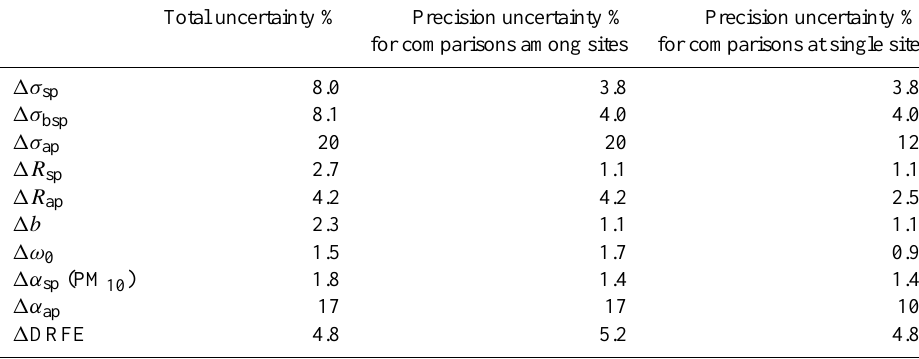
Table 3. Total and precision fractional uncertainties (%) of measured aerosol optical properties (AOPs) σ sp , σ bsp , and σ ap and calculated AOPs (e.g., the intensive AOPs) for 1h averaging time. Uncertainties are expressed as 95% confidence intervals. All calculated uncertainties are for λ = 550nm except for α sp and α ap , which are calculated for the 450/700nm wavelength pair. All AOPs are PM 1 except for PM 10 α sp and the PM 1 scattering and absorption fractions ( R sp and R ap , respectively). The uncertainties in columns 3 and 4 differ only by inclusion of the PSAP unit-to-unit variability term (Eq. S3) in column 3. All uncertainties except (cid:49)σ sp , (cid:49)σ bsp , and (cid:49)σ ap depend nonlinearly on the measured value, and cannot rigorously be represented as a percentage ∗ . For these intensive AOP uncertainties, we use approximate annual- fractional uncertainties. The intensive AOP fractional uncertainties apply for the average conditions listed above, and the equations in the Supplement should be used to calculate uncertainties at different sites or for different conditions. Total uncertainty % Precision uncertainty % Precision uncertainty % for comparisons among sites for comparisons at single